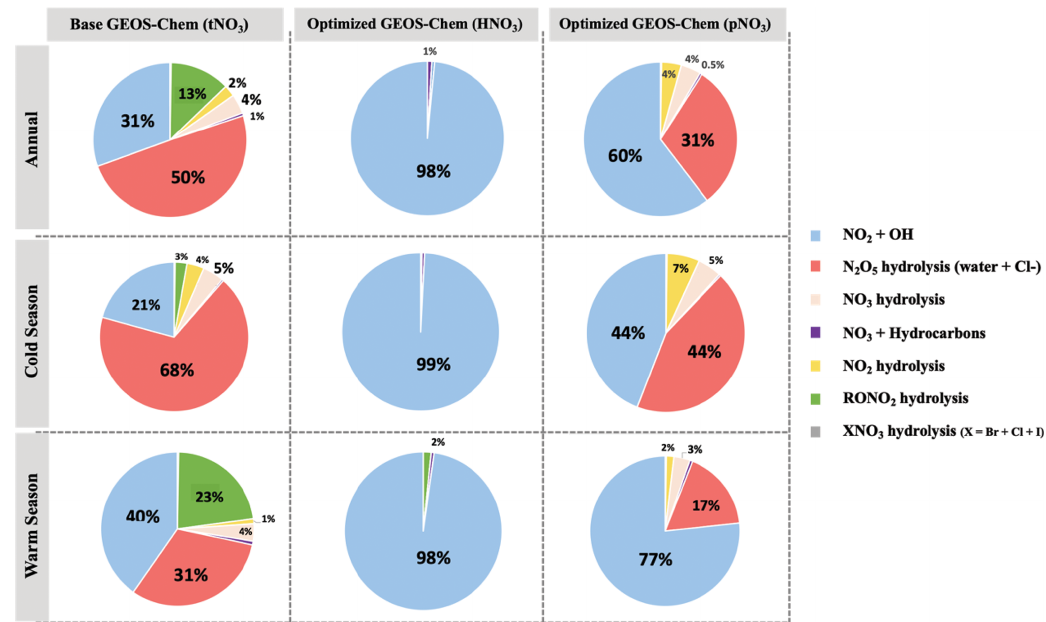
Figure 8. Relative proportions for major nitrate production pathways by season from base GEOS-Chem output (HNO 3 + pNO 3 ), optimized GEOS-Chem for HNO 3 production only, and optimized GEOS-Chem for pNO 3 production only based on comparison with observations across the three CASTNET sites. Annual refers to the full 2-year record (December 2016–December 2018). The cold and warm seasons refer to October–March and April–September,